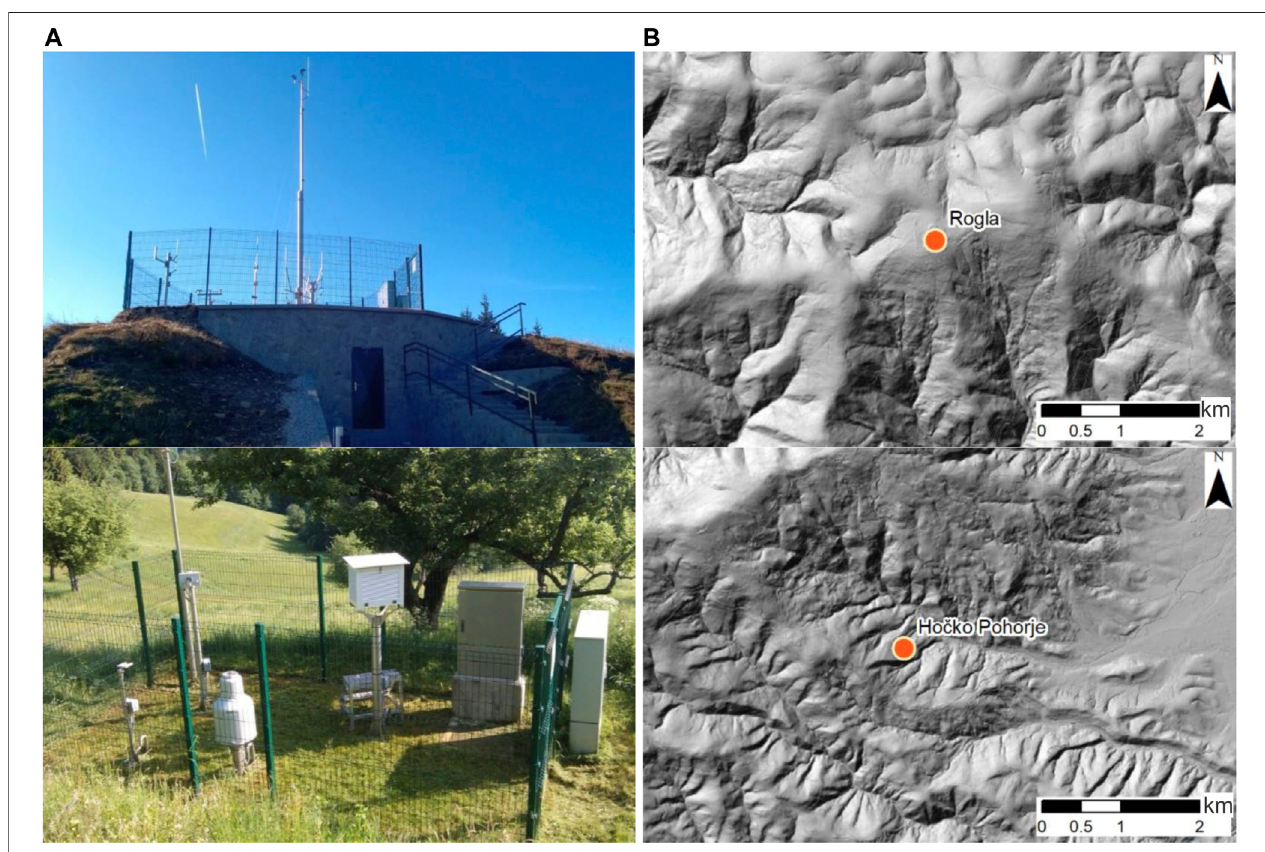
FIGURE 3 | Photos of Rogla and Ho č ko Pohorje meteorological stations (A) and their location on a hillshade map (B) . Hillshade source: Lidar Hillshade (http://gis. arso.gov.si/arcgis/rest/services/Lidar_hillshade/MapServer/WMTS).